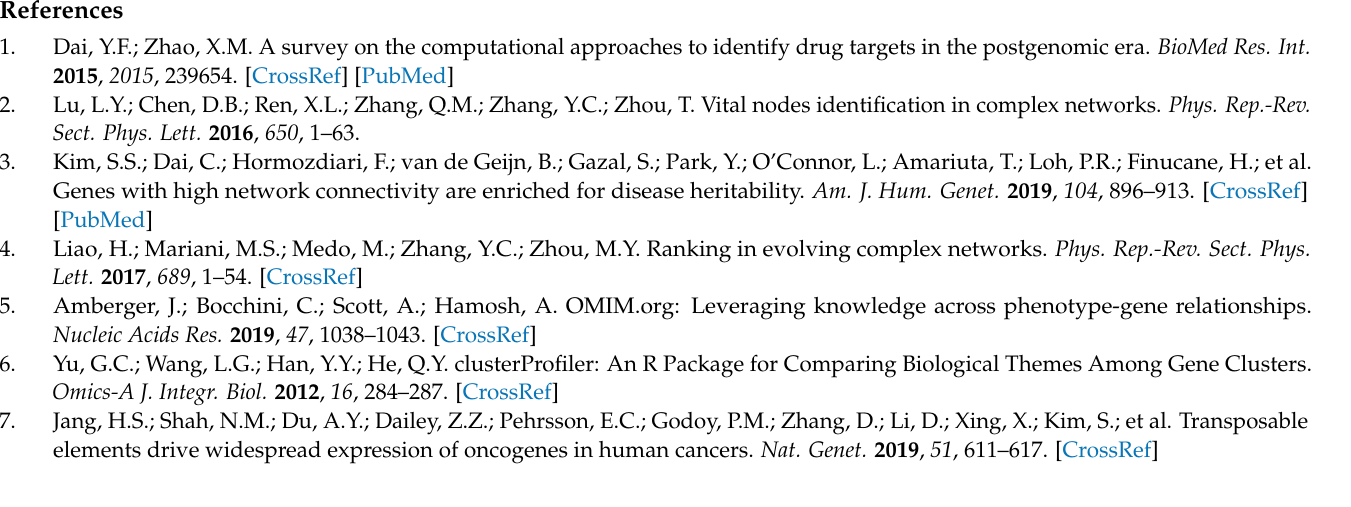
Table S5: The core genes were found using the MCC algorithm; Table S6: Use HopcroftCKarp algorithm to get 214 drive nodes based on control centrality; Table S7: Use MCODE, ClusterOne and Connected Components to divide disease network modules and calculate entropy results; Table S8: In-degree, out-degree and difference between in-degree and out-degree of three HNS; Table S9: Chronos dependency scores of CM (core module), CN (core nodes), and DN (driver nodes) in 186 ovarian cancer cell lines; Table S10: Canonical Pathways of differentially transcribed genes in OVA; corrected p < 0.05; Table S11: 2362 risk prognostic genes and its distribution in CM, CN, DN; Table S12: 2825 differentially transcribed genes in normal cell versus ovarian cancer patients, corrected p < 0.05; |FC| ≥ 1.5; Figure S1: Gene Ontology of eight hub genes was constructed by integrating WikiPathways, Reactome, and KEGG; Figure S2: Analysis of CM, CN, and DN; (A) The GO biological functions of CM; (B) CN; and (C) DN by enrichment